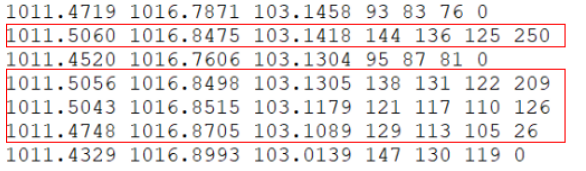
Figure 9. ASCII file produced using the Agisoft-Metashape software